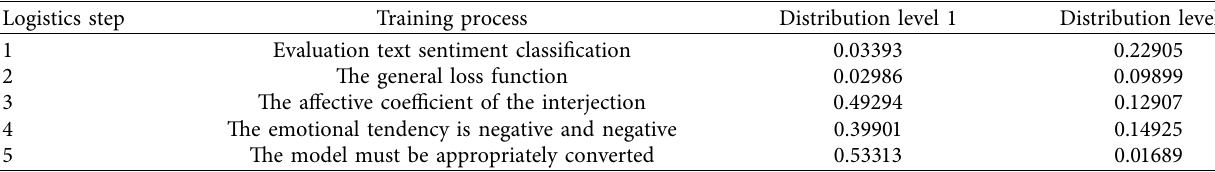
Table 3: Distribution of weights of logistics data